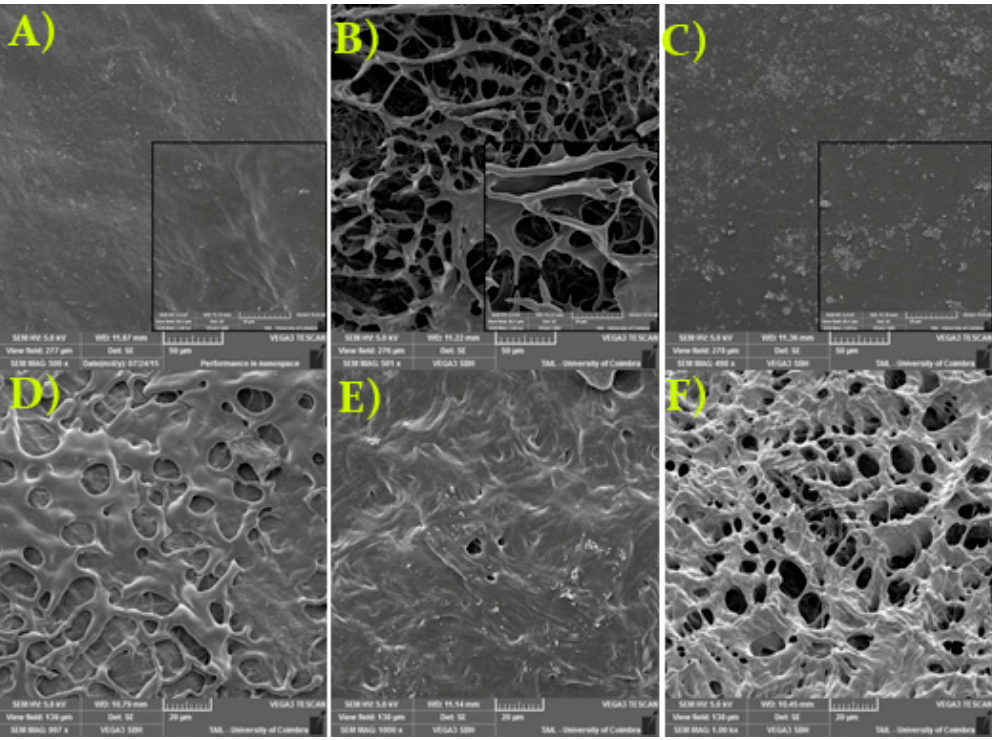
Figure 5. Scanning electron micrographs of composite hydrogels based on PVA/CS/MA- β -CD at 500× magnification, which presented a low ( A ), intermediate ( B ), and high ( C ) swelling degree. Insert figures, SEM images at 2000× magnification. Blanks-PVA (100%; D ); PVA (88.6% v / v ) + CS (11.4% v / v ; E ); and PVA (94.25% v / v ) + MA- β -CD (5.75% w / v ; F ), at 1000× magnification.